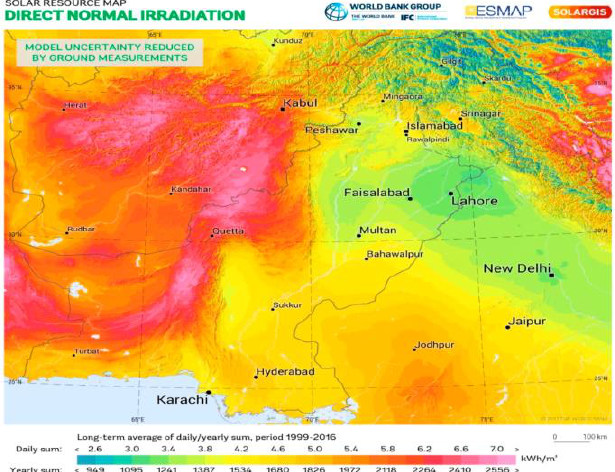
Fig. 6. Annual solar radiation map of Pakistan, reprinted with permission of Elsevier [16, 17]